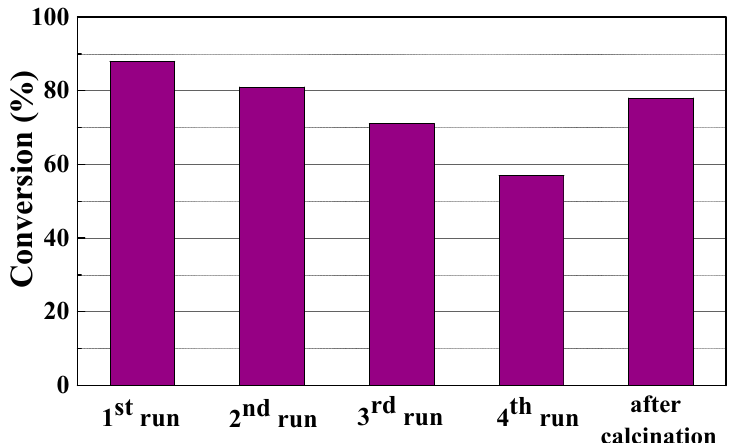
Figure 10. Reuse of the PILC as catalyst in the esterification reaction between FACO and EH after four reaction cycles and after calcination at 500 °C. Catalytic conditions: EH:FACO molar ratio of 1.5, reaction temperature: 50 °C, reaction time: 6 h, catalyst to FACO ratio: 6 g/100 g, zeolite 3A to FACO ratio: 10 g/100 g.